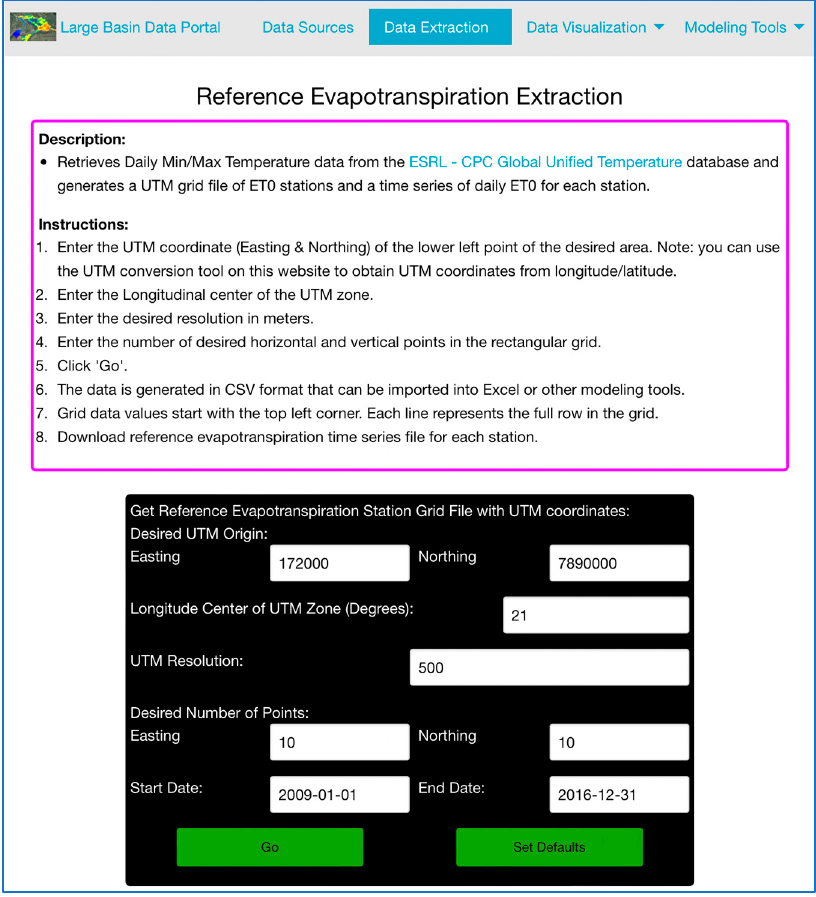
Figure 6. Screenshot of the Large Basin Data Portal reference evapotranspiration (ET 0 ) calculator with description, usage instructions, and input parameters.